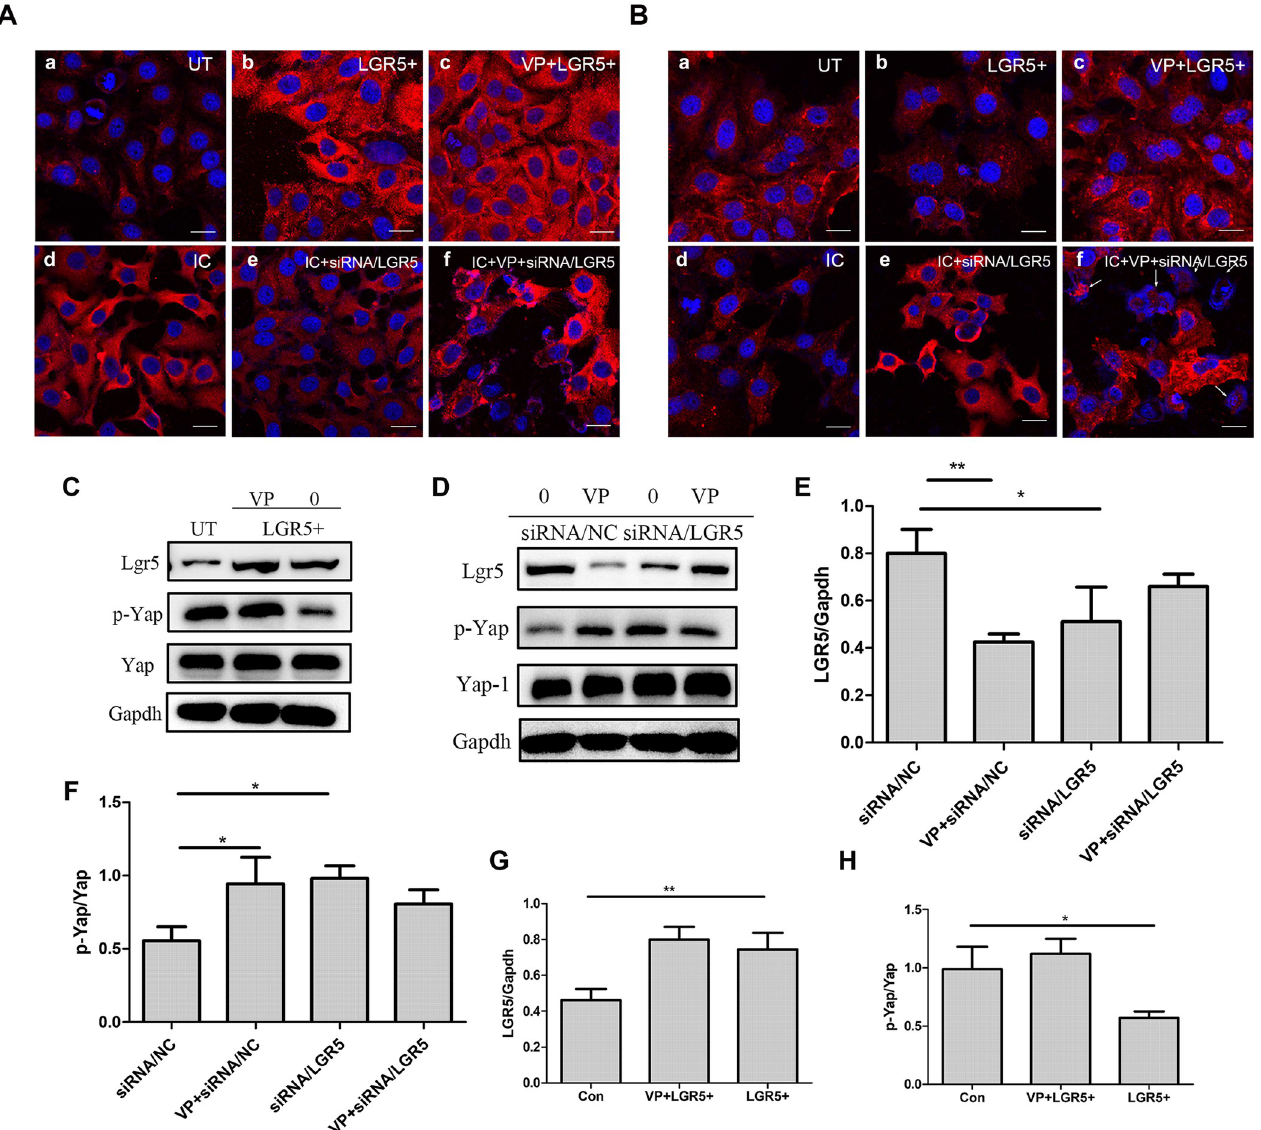
Fig 5. Relationship between the phosphorylation of YAP and LGR5 expression. A: LGR5 expression was detected by immunofluorescence assay. FaDu cells were subjected to immunofluorescent staining for Hoechst 33342 (blue) and LGR5 (red). The cells were subjected to various treatments: transfection with LGR5 plasmids or stimulation with the inflammatory condition; inhibition of LGR5 expression by siRNA; inhibition of YAP phosphorylation by VP. The experimental results of immunofluorescence of LGR5 expression are shown in A,Scale bar = 20 μ m. The expression of p-YAP was detected by immunofluorescence assay. The results of p-Yap expression are shown in B. FaDu cells were subjected to immunofluorescent staining for Hoechst 33342 (blue) and phosphorylated YAP (red). C-H: Western blotting was used to detect LGR5 or p-YAP expression in LGR5-overexpressed cells or siRNA/LGR5-transfected FaDu cells. Statistical significance is denoted by � P < 0.05 �� P < 0.01. UT: untreated group; IC: inflammatory condition; VP: verteporfin; LGR5+: stable cell lines overexpressing LGR5; siRNA/NC: negative control siRNA; siRNA/LGR5: LGR5